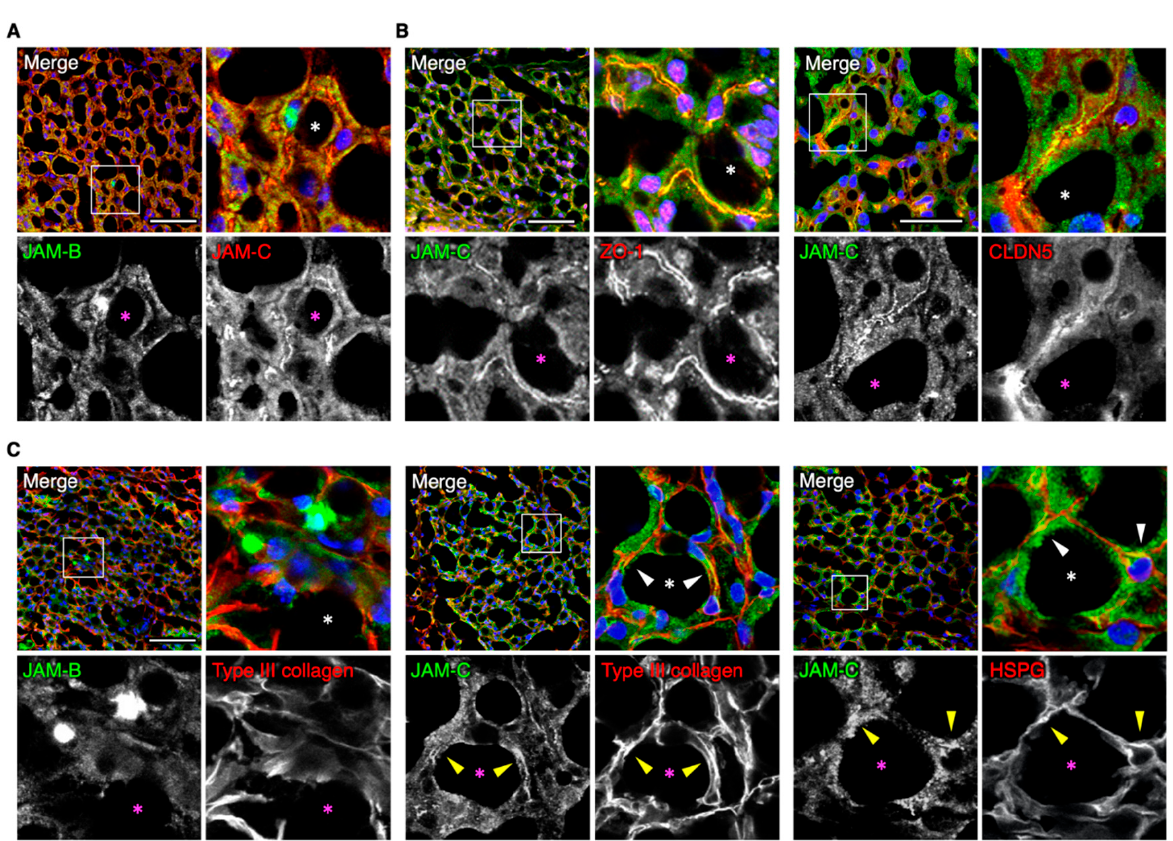
Figure 3. JAM-C is widely distributed in the fat interstitial tissues. ( A – C ) Confocal images of mouse ADSCs stained for the indicated markers. Asterisks indicate lipid droplets in differentiated adipocytes, and arrowheads show colocalization of JAM-C and ether type III collagen or heparan sulfate proteoglycan (HSPG). Squares show the enlarged areas. Scale bars, 50 µm.